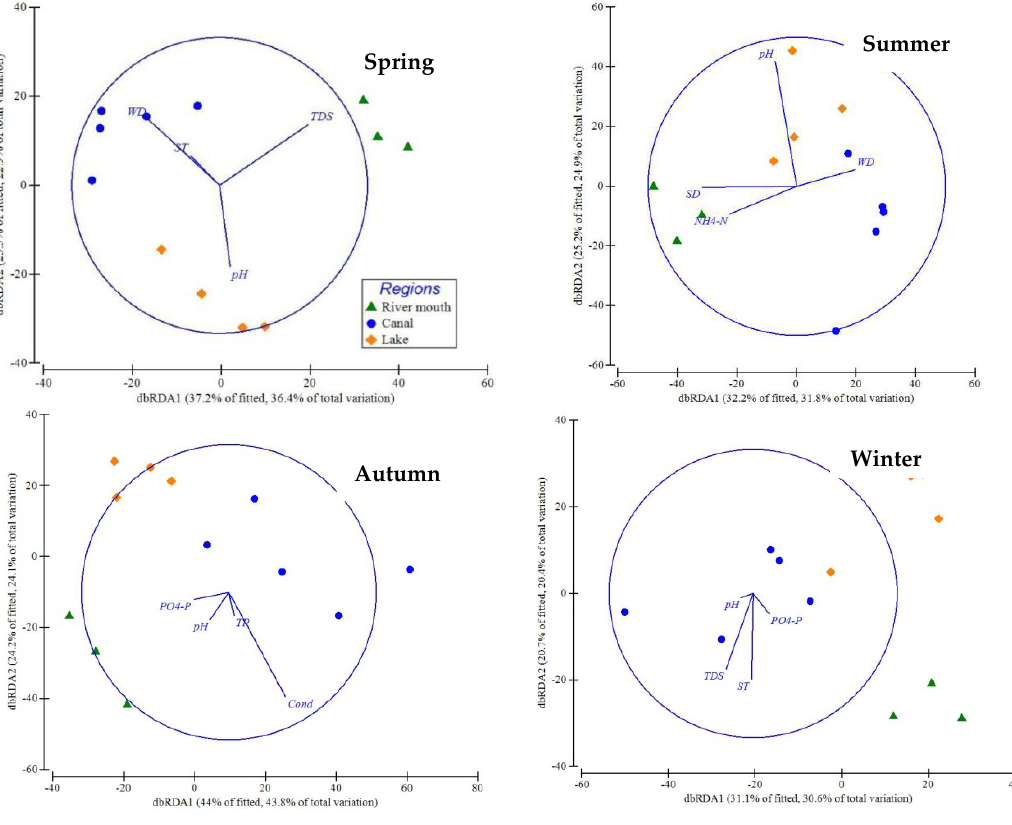
Figure 5. Ordination of distanced-based redundancy analysis (db-RDA) of macroinvertebrate assemblages to environmental parameters among seasons. Table 5. Results of distance-based redundancy analysis (db-RDA), giving the relative influence of significant environmental variables on community composition in the four seasons.